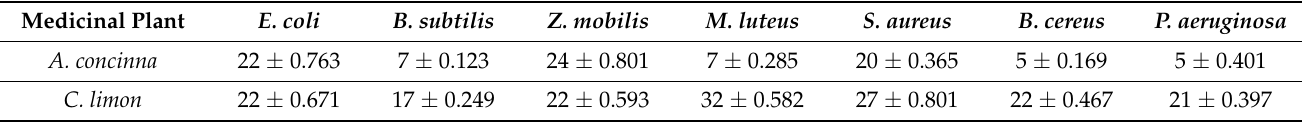
Table 3. Zone of bacterial clearance of various extracts in mm. Medicinal